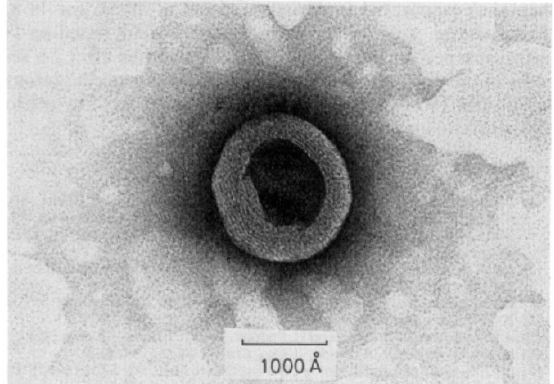
Figure 2. Electron micrograph of didodecyldimethylammonium bromide vesicles. (240,000 X). The sample solution was sonicated in the presence of uranyl